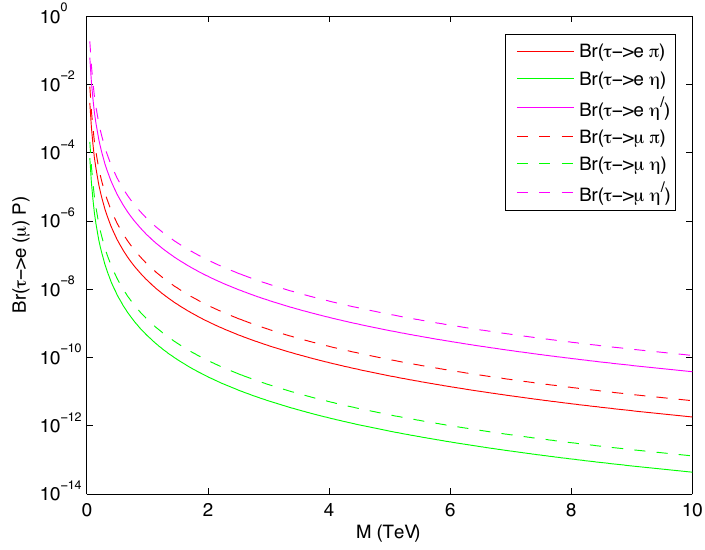
Figure 4 . Dependence of the branching ratios Br( (cid:28) + ! ‘ + P ) on the new neutral gauge boson mass m Z 0 (cid:17) M , where ‘ = e; (cid:22) and P = (cid:25); (cid:17); (cid:17) 0 . Here, lepton mixing angles and phase (cid:18) ‘ (cid:18) ‘ = (cid:25)= 6, (cid:18) ‘ = (cid:25)= 4, and (cid:14) ‘ = 0 have been 13 23